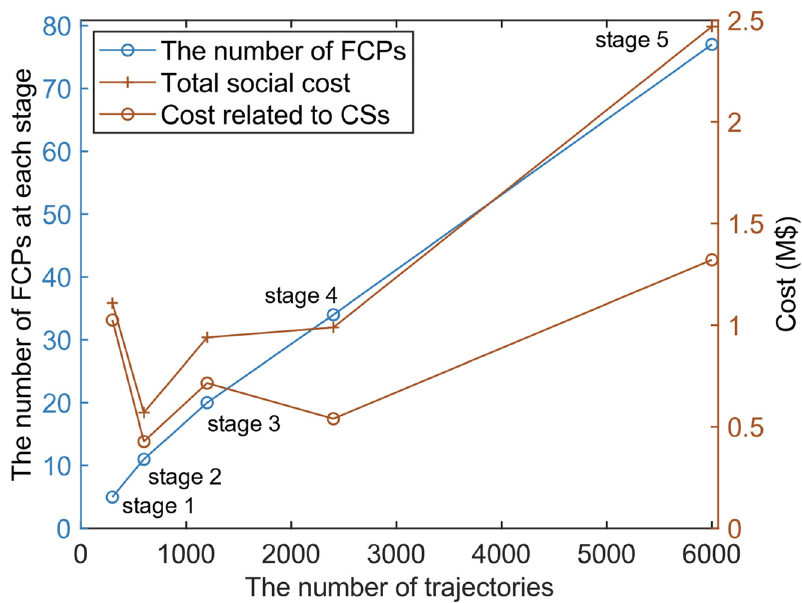
Figure 6. Optimization results based on the Sioux Falls road network.